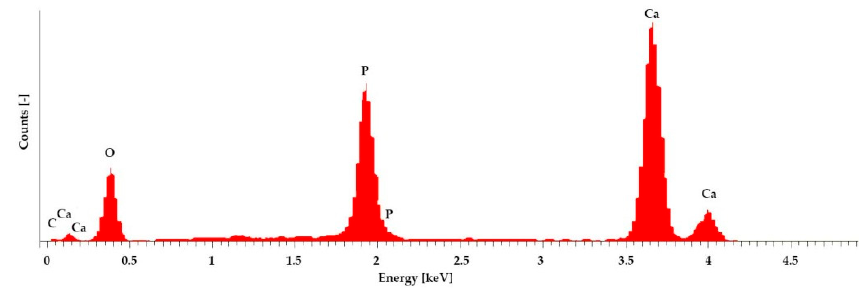
Figure 3. EDX spectrum of the samples, taken with an FEI Quanta ESEM 250 FEG and an Oxford EDX unit, 10 kV acceleration voltages, and 10 min counting period live time corrected. Table 6. Proportions of relevant elements in the EDX spectrum .